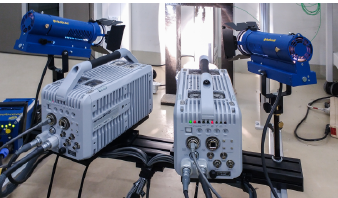
Figure 2. High-speed stereo camera system.